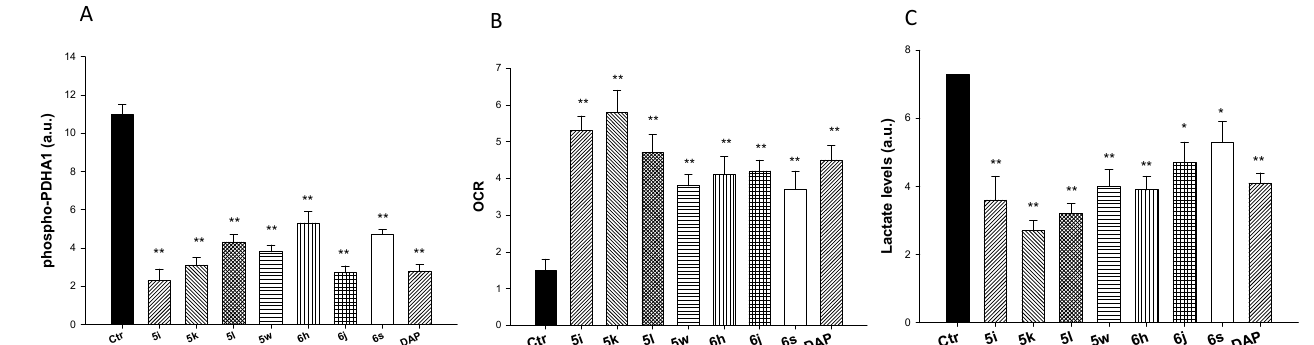
Figure 8. Effects on PDH phosphorylation, oxygen consumption and glycolytic metabolism in PSN-1 cells treated for 24 h with test compounds. ( A ) Phosphorylation levels of S232 PDH E1 alpha protein (PDHA1) were assessed by ELISA Kit (ab115343). ( B ) Changes in cellular oxygen consumption were assessed by the Mito-ID® Extracellular O 2 Sensor Kit. Fluorescence was estimated at 360 nm (excitation) and 650 nm (emission). ( C ) Changes in lactate production were assessed by a lactate assay kit (Merk). Error bars indicate S.D. Data are the means ± SD of three independent experiments. * p < 0.05, ** p < 0.01.